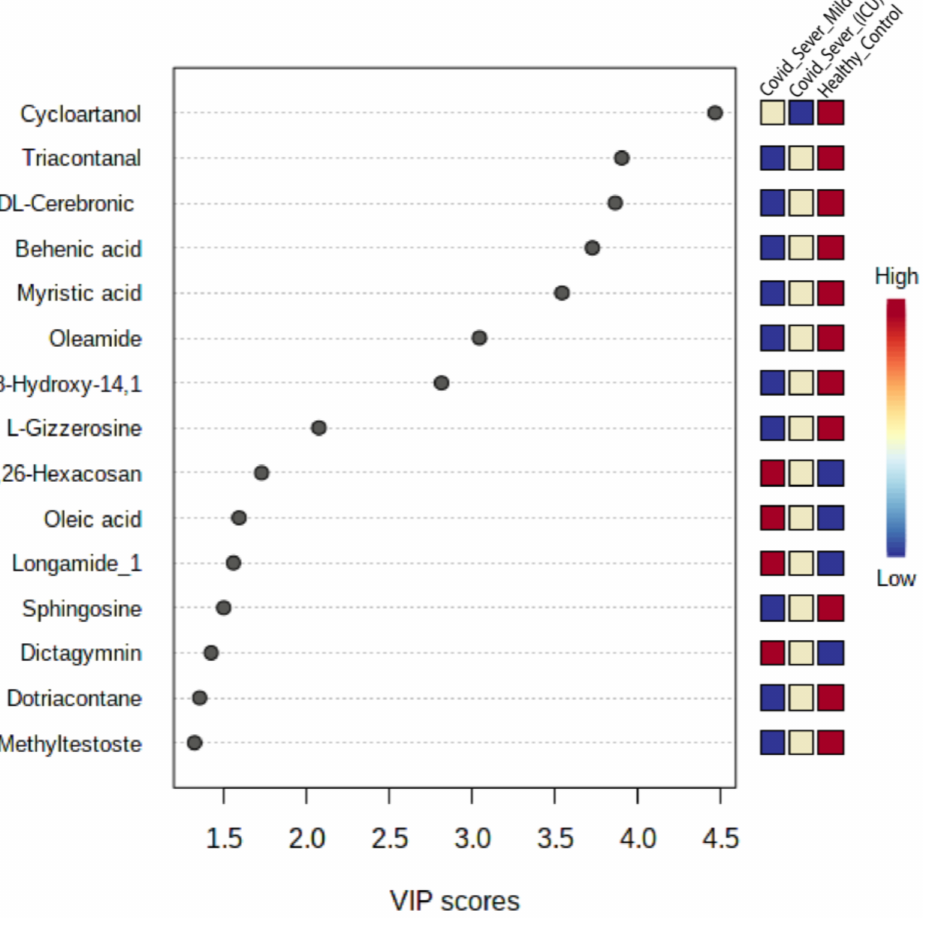
Figure 8. PLS-DA analysis for identification of crucial metabolites associated with disease. The colored boxes on the right indicate the relative concentration of the corresponding metabolites from EVs that are taken from both healthy and COVID-19 patient